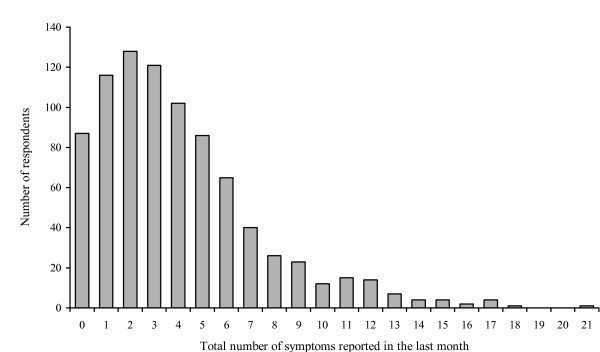
Distribution of total number of symptoms experienced in the last month based on self report from a list of 33 symptoms.